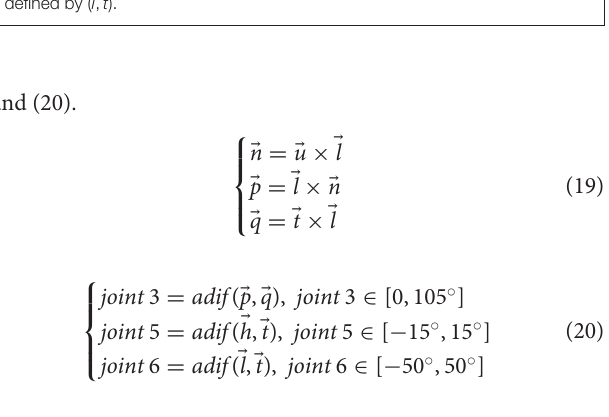
FIGURE 5 | The explanation of spatial relations by which the posture controller works. Vectors E u , E l , E h are along the spatial directions of upper arm, lower arm and hand, respectively. Vectors E n and E p are the normal vectors of planes defined by ( E u , E l ) and ( E l , E n ), respectively. Vector E t represents the desired direction when the end-effector reaches the target. E q is the normal vector of the plane defined by ( E l , E t ).